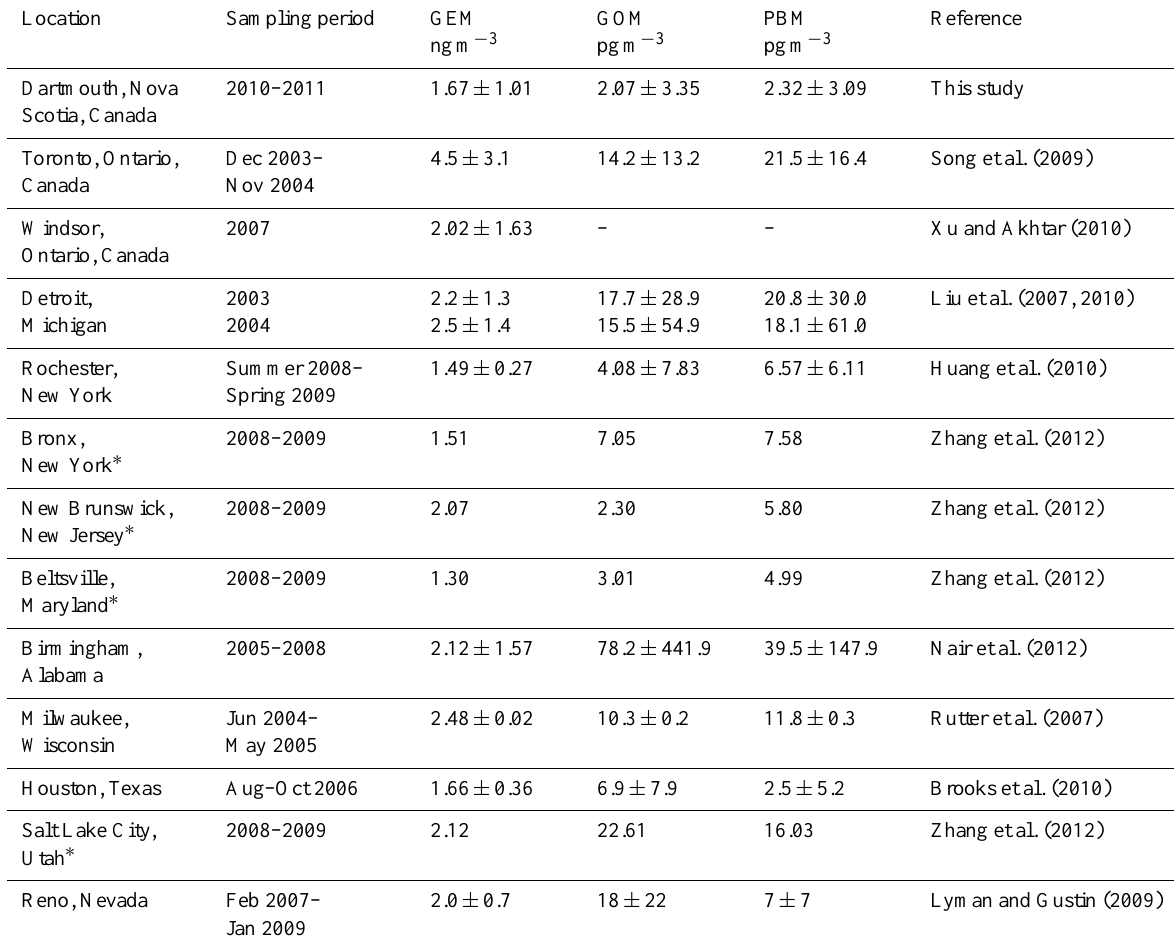
Table 1. Speciated atmospheric Hg concentrations (mean ± standard deviation) at Dartmouth and urban locations in Canada and United